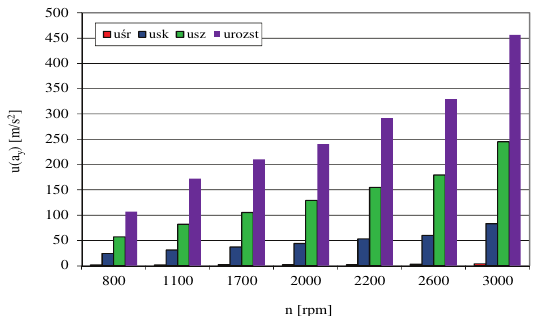
Fig. 5. Mean, RMS, peak and peak-to-peak value of vibration accelerations for Y dimension and different engine speeds